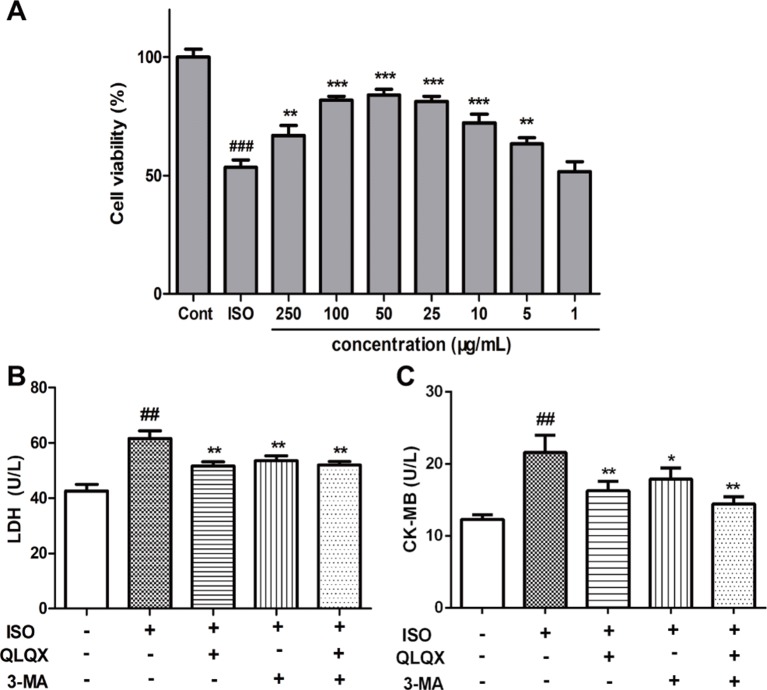
QLQX improves cell viability and alleviates ISO-induced myocardial injury in H9c2 cells, which is similar to the treatment by 3-MA. (A) The viability of H9c2 cells was tested by MTT in different concentrations of QLQX. (B) The release of LDH in the culture medium in different groups. (C) The activity of CK-MB in the culture medium in different groups. Data are expressed as mean ± SD, n = 3. ##
p < 0.01, ###
p < 0.001 versus control group; *p < 0.05, **p < 0.01, ***
p < 0.001 versus ISO group. QLQX, Qi-Li-Qiang-Xin, ISO, isoproterenol.